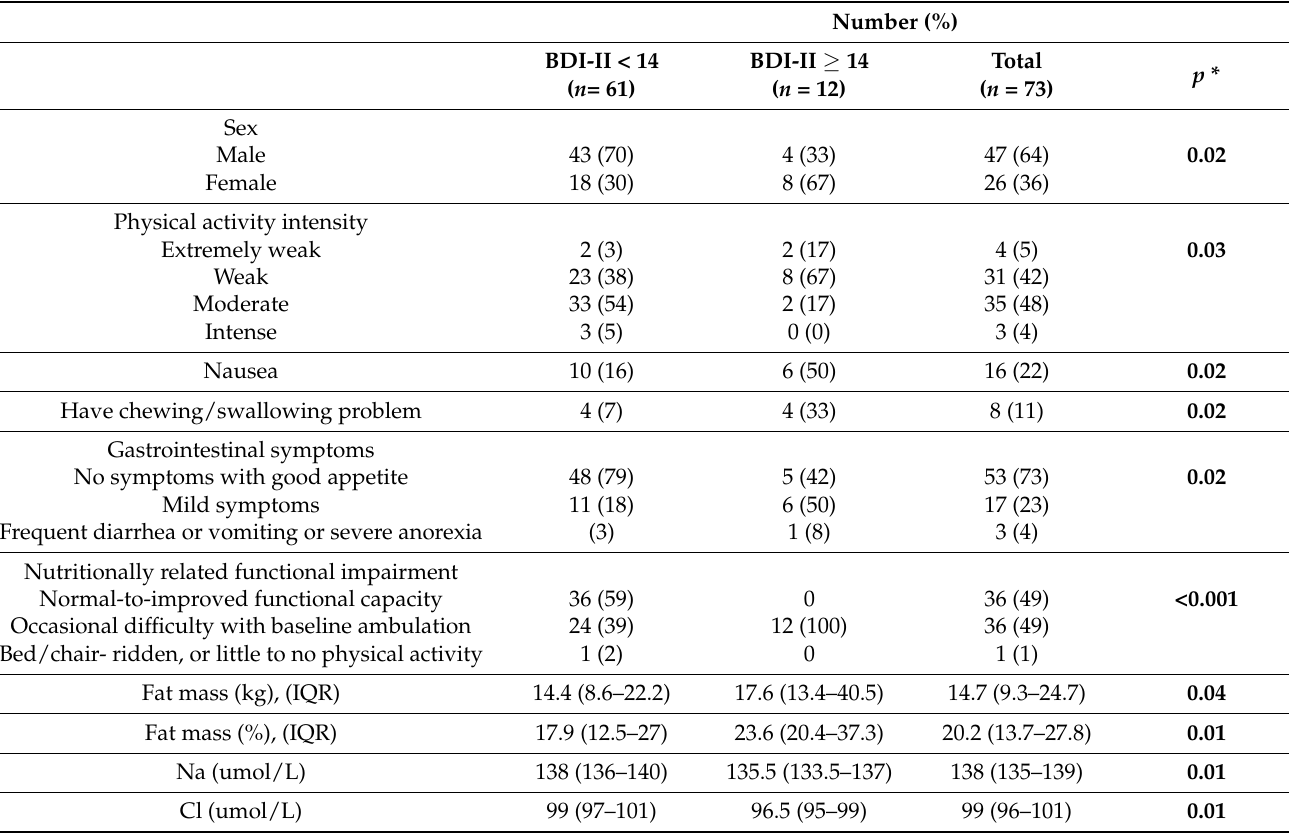
Table 3. Significant differences between measured parameters regarding the presence of depressive